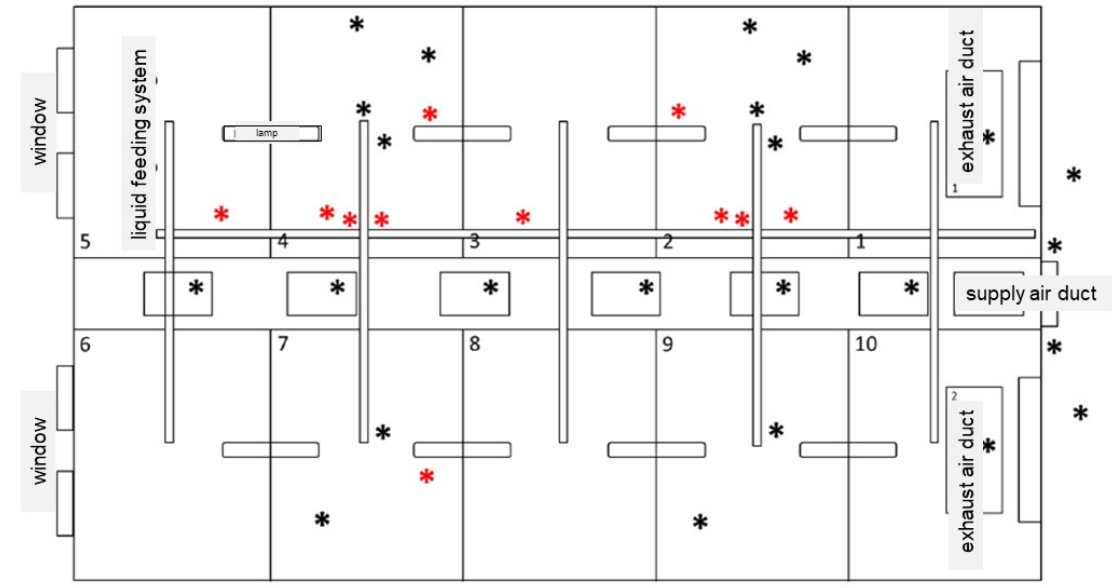
Figure 5. Schematic overview of the sampling locations in the upper part of the test compartment (>2 m height). * Black dots: easy to clean areas. * Red dots: difficult to clean areas. Swabs with Amies transport medium (VWR) were used for sampling of the surfaces. Depending on the location of the sampled area, defined areas (20 cm 2 , 4 × 5 cm) or distances (10 cm × 2 cm) were